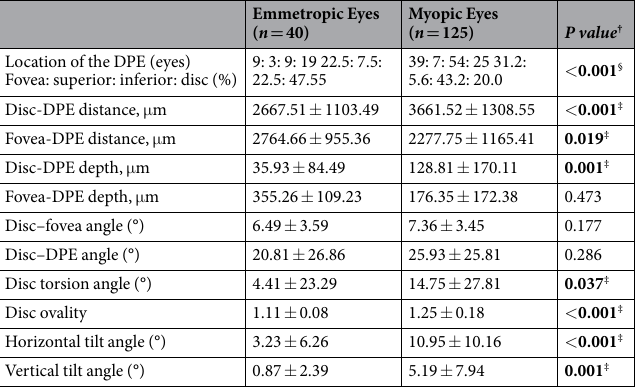
(12.0 ± 8.1°) of the 4 groups (Table 4).